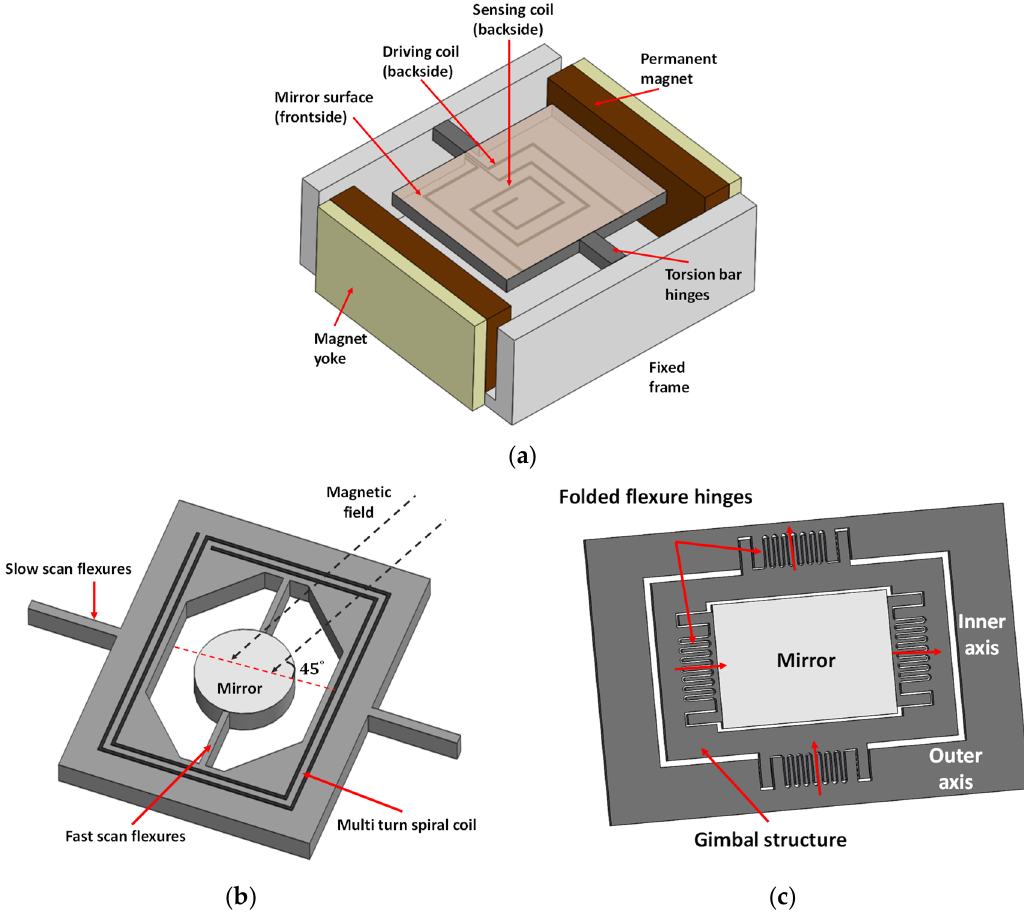
Figure 4. Schematic of the mechanical structures of a ( a ) 1D scanner in Olympus confocal microscope Figure4. Schematicofthemechanicalstructuresofa( a )1DscannerinOlympusconfocalmicroscope[32]; [32]; ( b ) 2D scanner with an external magnet set at 45° to the plane of the scanning axis [34]; ( c ) 2D ( b ) 2D scanner with an external magnet set at 45 ◦ to the plane of the scanning axis [34]; ( c ) 2D scanner scanner driven by the glued magnets on the side of the mirror [35]. driven by the glued magnets on the side of the mirror